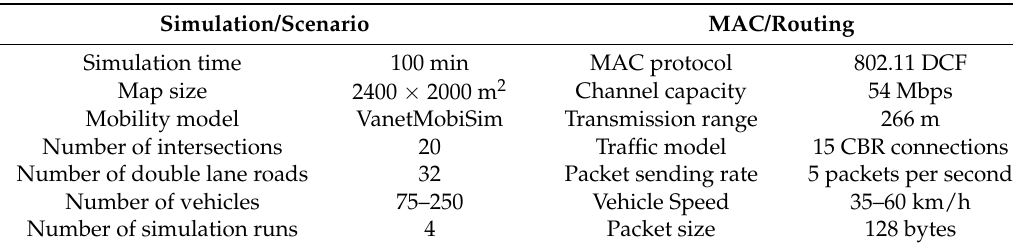
Table 1. Simulation